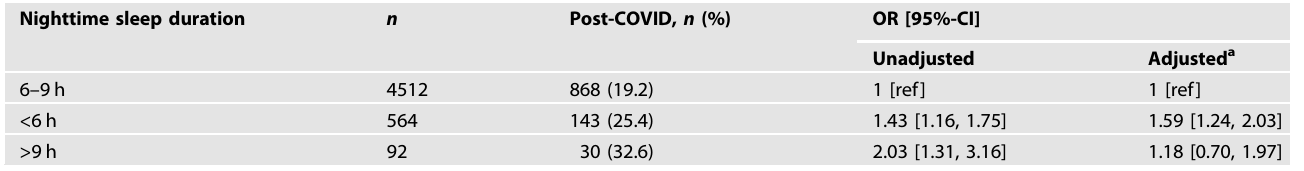
Table 4. Association of habitual nighttime sleep duration with post-COVID among those who received two mRNA vaccine doses and exhibited persistent sleep duration patterns between before the pandemic and during the pandemic.